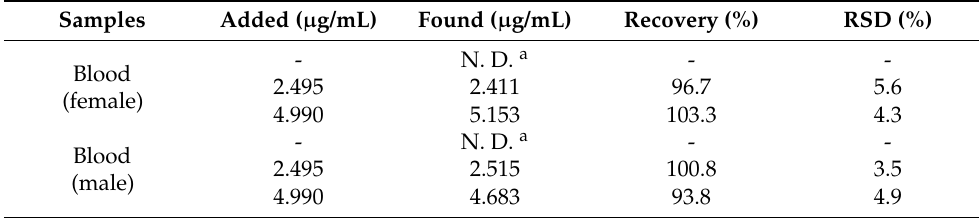
Table 1. Quantification of MOR in samples (n = 3).